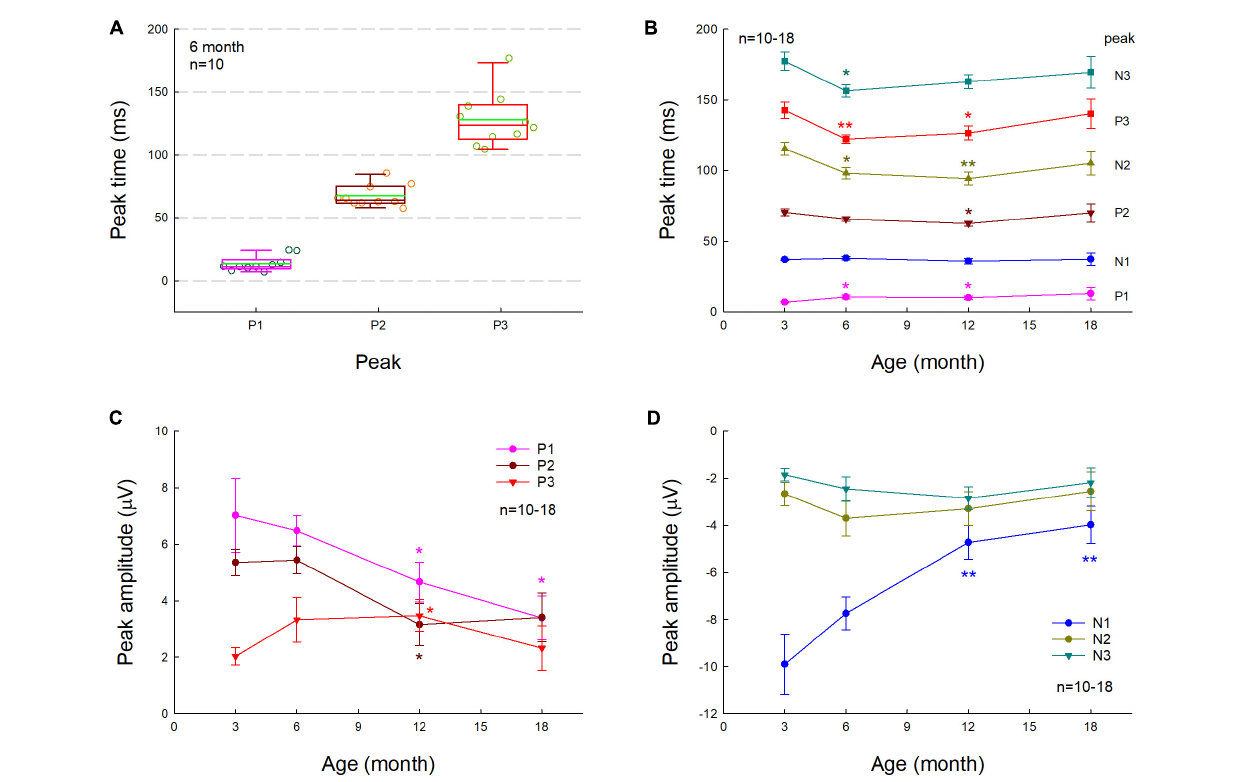
FIGURE 2 | Changes of AECP in normal aging CBA/CaJ mice. N is the mouse number. (A) P1, P2, and P3 peak times at the age of 6 months old. The green line in the box represents the mean level. (B) Changes of AECP peak times in normal aging. The statistical t -tests were performed by comparing peak times at the defined age to that at 3 months old in each peak. (C,D) Changes of peak amplitudes with aging. The amplitudes of early peaks P1, N1, and P2 in AECP are decreased with aging, whereas the peak amplitudes of later waveforms N2, P3, and N3 are increased or have no significant change with aging. The statistical analyses were performed by comparing peak amplitudes at the defined age to that at age of 3 months old in each peak. * p < 0.05, ** p < 0.01, t -test,